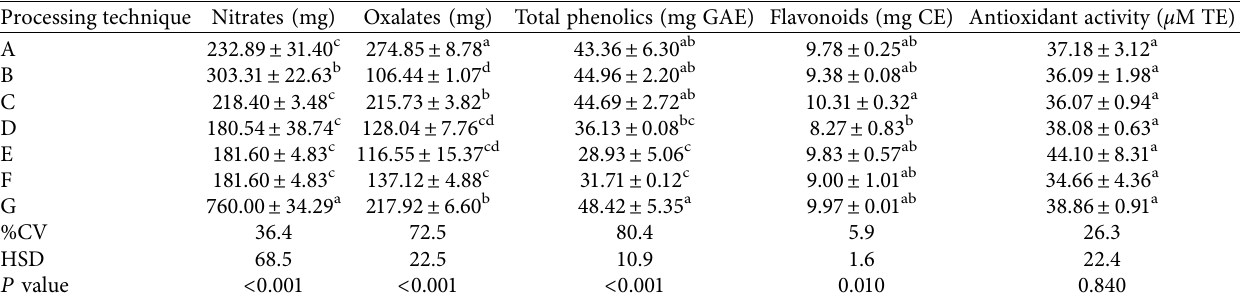
Table 12: Antinutrient content of optimally processed cowpea leaves (100g dry matter basis). Processing technique Nitrates (mg)